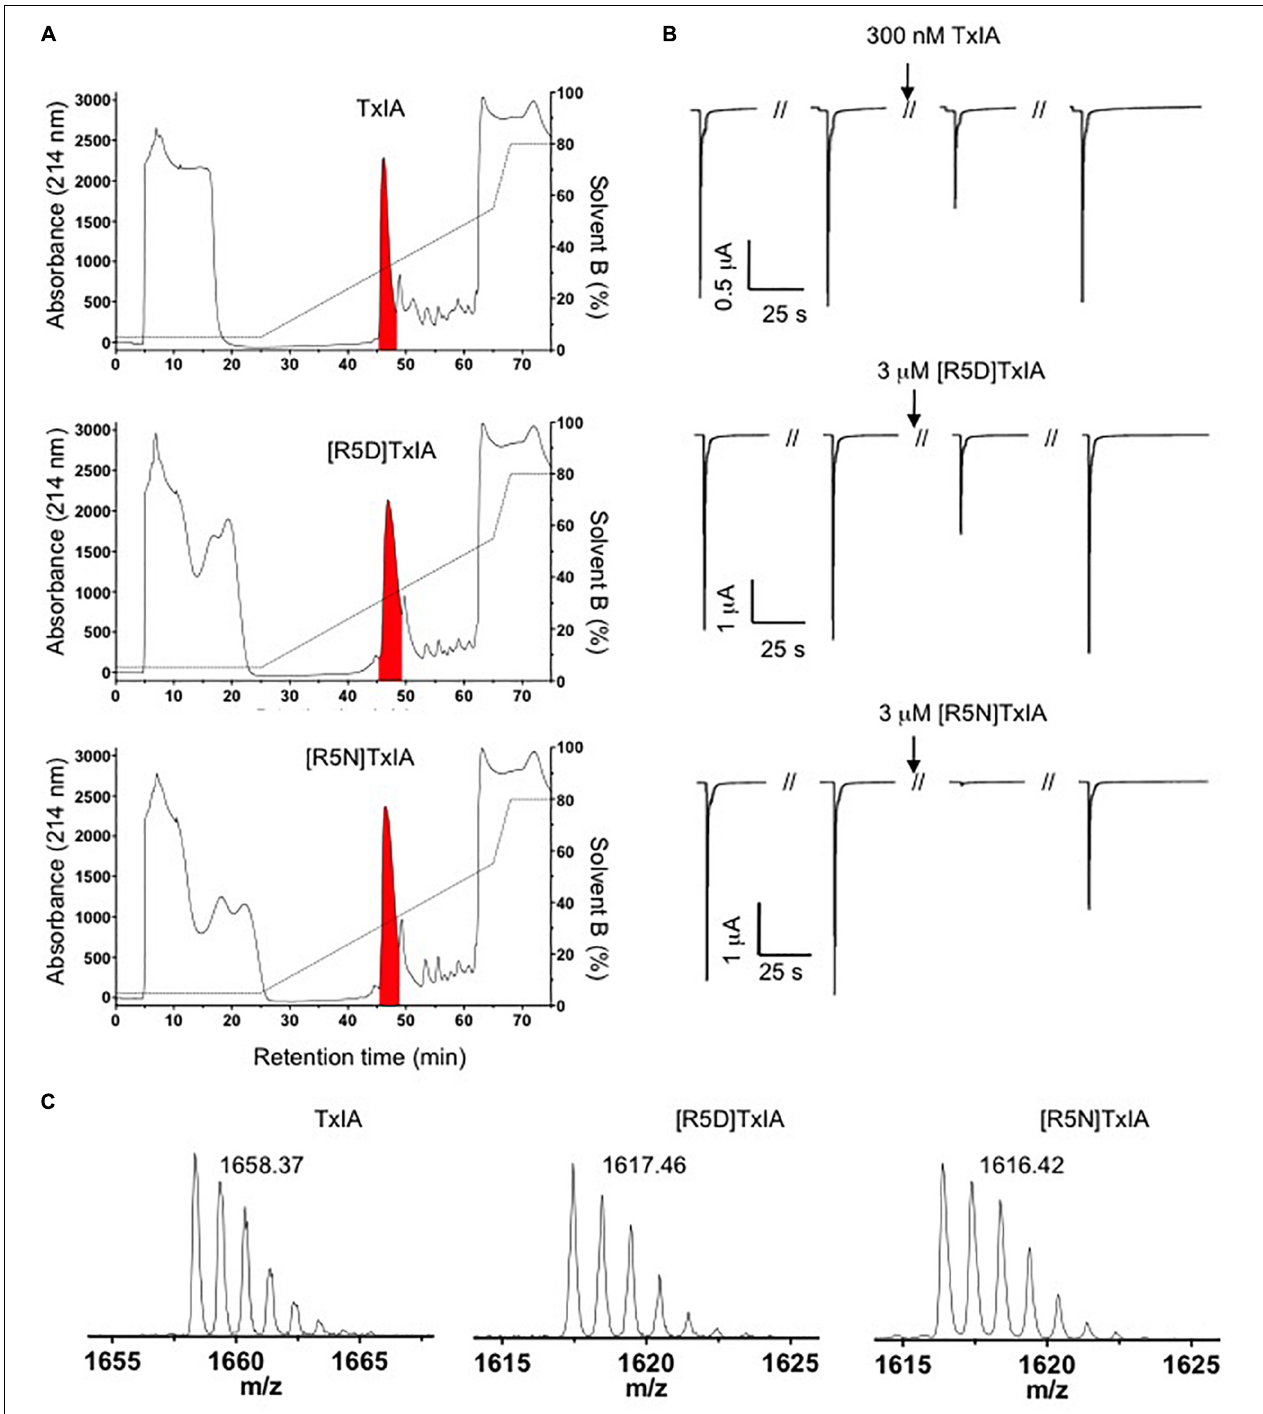
FIGURE 2 | Purification of TxIA and mutant (R5D, R5N) analogs. (A) RP-HPLC chromatograms showing first step RP-HPLC fractionation with the peaks highlighted in red containing the correct molecular mass as determined by MALDI MS. (B) Antagonistic activity of the purified toxin peak (i.e., the red peak from A ) at α 3 β 2 nAChRs. Oocytes were clamped at –70 mV and 100 mM ACh were used to activate α 3 β 2 nAChRs. (C) MALDI MS traces after second step HILIC fractionation of the purified TxIA and analogs (red colored fractions in Supplementary Figure S2 ) indicate the monoisotopic molecular masses of the purified toxins. All reported masses are for [M + H] +